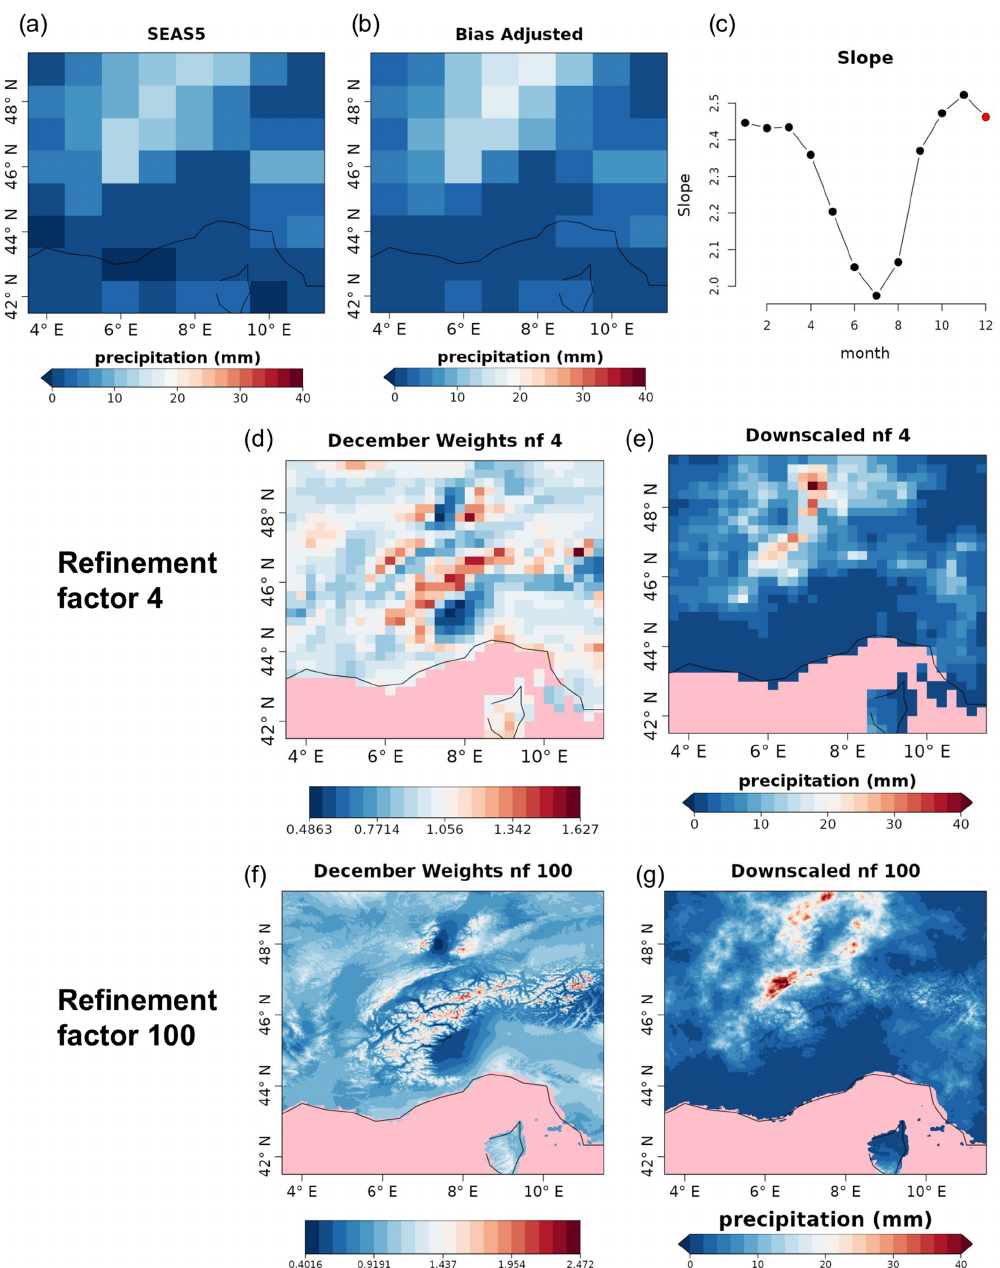
Figure 11. One out of 25 ensemble members of the original ensemble (a) large-scale precipitation field for SEAS5 for 11 December 1993 to be downscaled, (b) a bias-corrected field, and (c) monthly slopes (the slope used for downscaling is highlighted in red). In the middle (refinement factor 4) and bottom (refinement factor 100) rows, the comparison of the weights (d, f) and the downscaled (e, g) precipitation fields for SEAS5 for 11 December 1993 are shown. Grid points for which no data are available are colored in